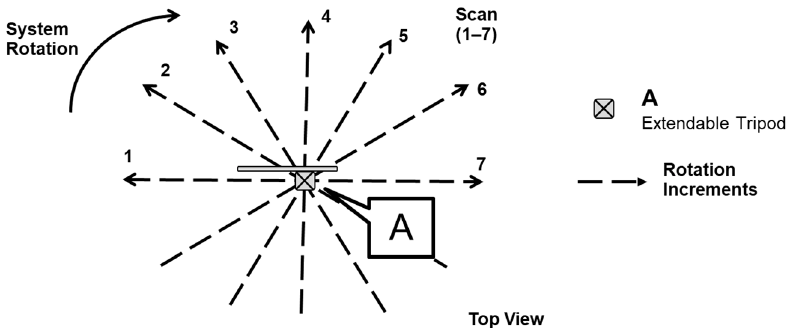
Figure 4. Illustration of SMART system rotation at a given station. Scan 1 to 7 leads to a 180° rota- tion of the pole in approximately 30°